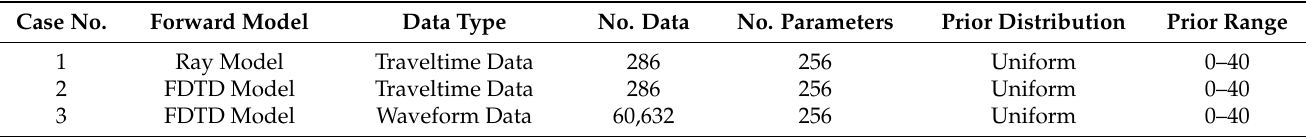
Table 1. Bayesian inversion parameters using uniform